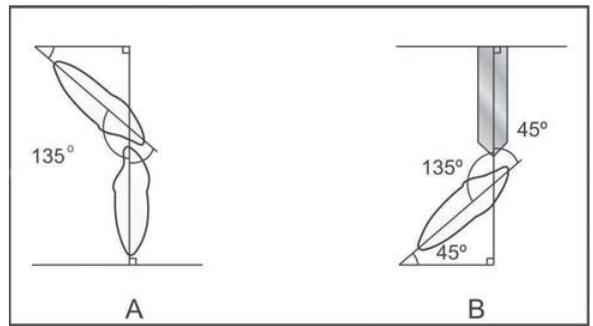
FIGURE 1- The specimens were subjected to load at 45 degrees on a universal testing machine (crosshead